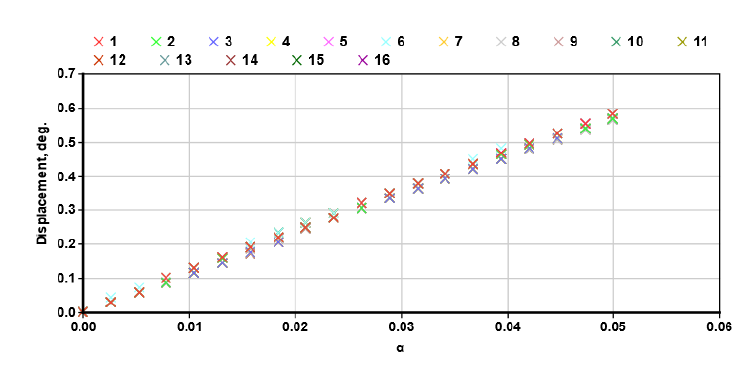
Fig. 2. Relation between the electric axis displacements and the reflector deformation.